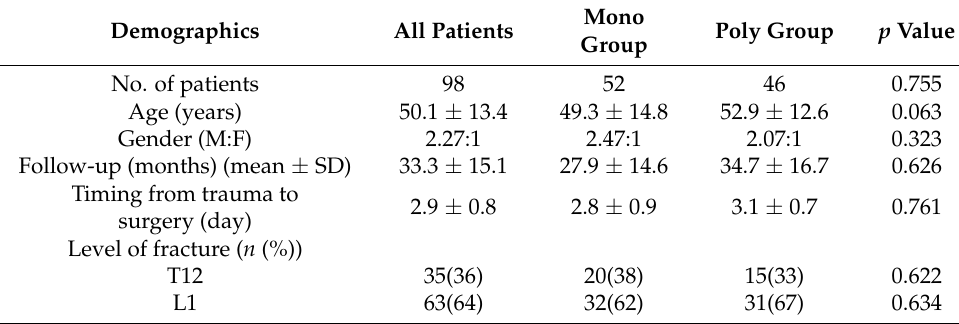
Table 1. Summary of demographic